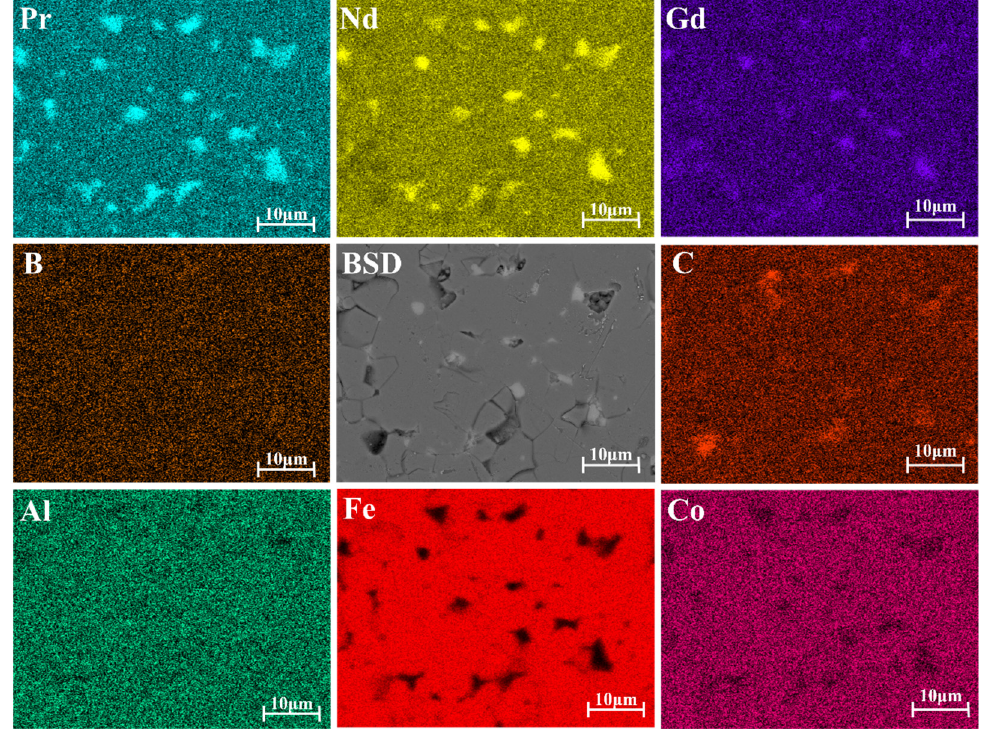
Figure 1. High-resolution EDS mapping of the main elements on the spent NdFeB magnet surface.